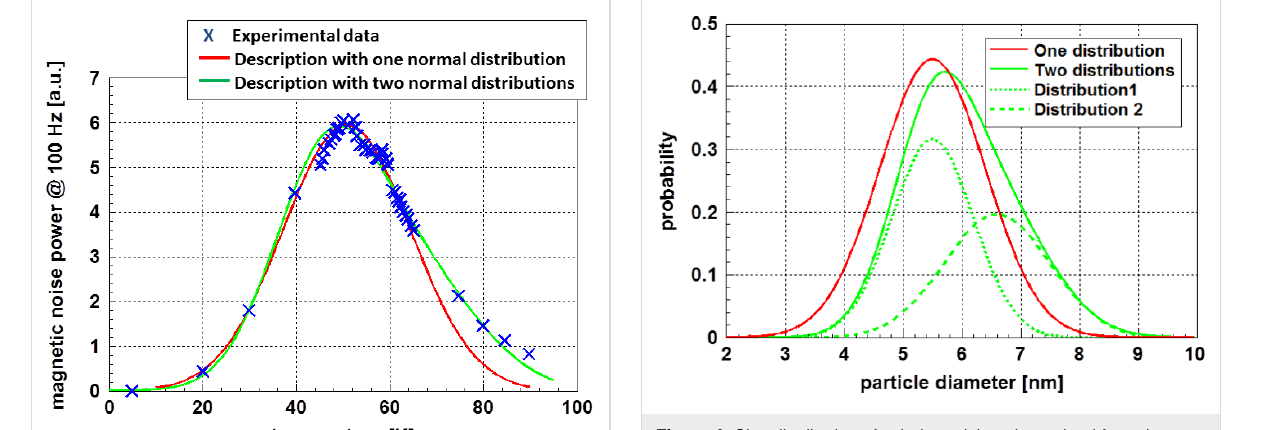
Figure 4: Size distribution of cobalt particles, determined from the transition to superparamagnetic state [5]. Two assumptions were made for the particle size distribution: (1) A normal distribution with the pa- rameters = 5.5 nm and (red curve) σ = 0.85 nm, similar to that assumed by Woods et al. [5] and (2) an extended distribution as a superposition of two normal distributions (green curves) with the pa- rameters = 5.5 nm and σ 1 = 0.7 nm. Taking into account the ex- tended tail of the particle size distribution on the side of the larger parti- cles, a second normal distribution with the parameters = 6.6 nm and σ 2 = 0.9 nm was introduced. In both cases, the experimental data given by Woods et al. [5] are well reproduced. However, the assump- tion of a broader size distribution also takes care of the particles in the tail on the side of the larger